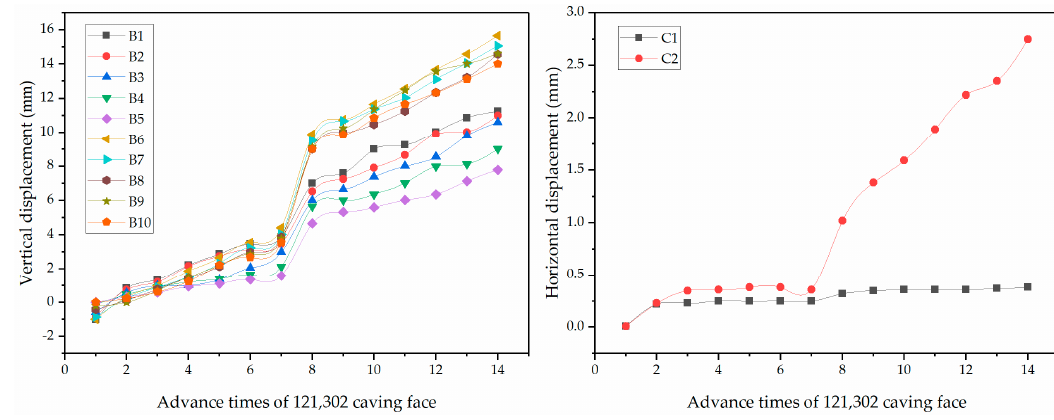
Figure 6. Vertical and horizontal displacement curves of measuring lines B and C.